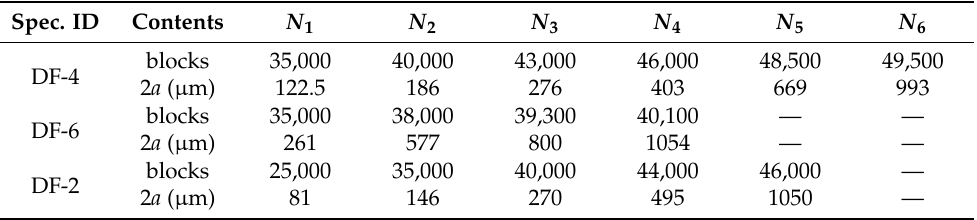
Table A1. Crack lengths versus loading blocks of different